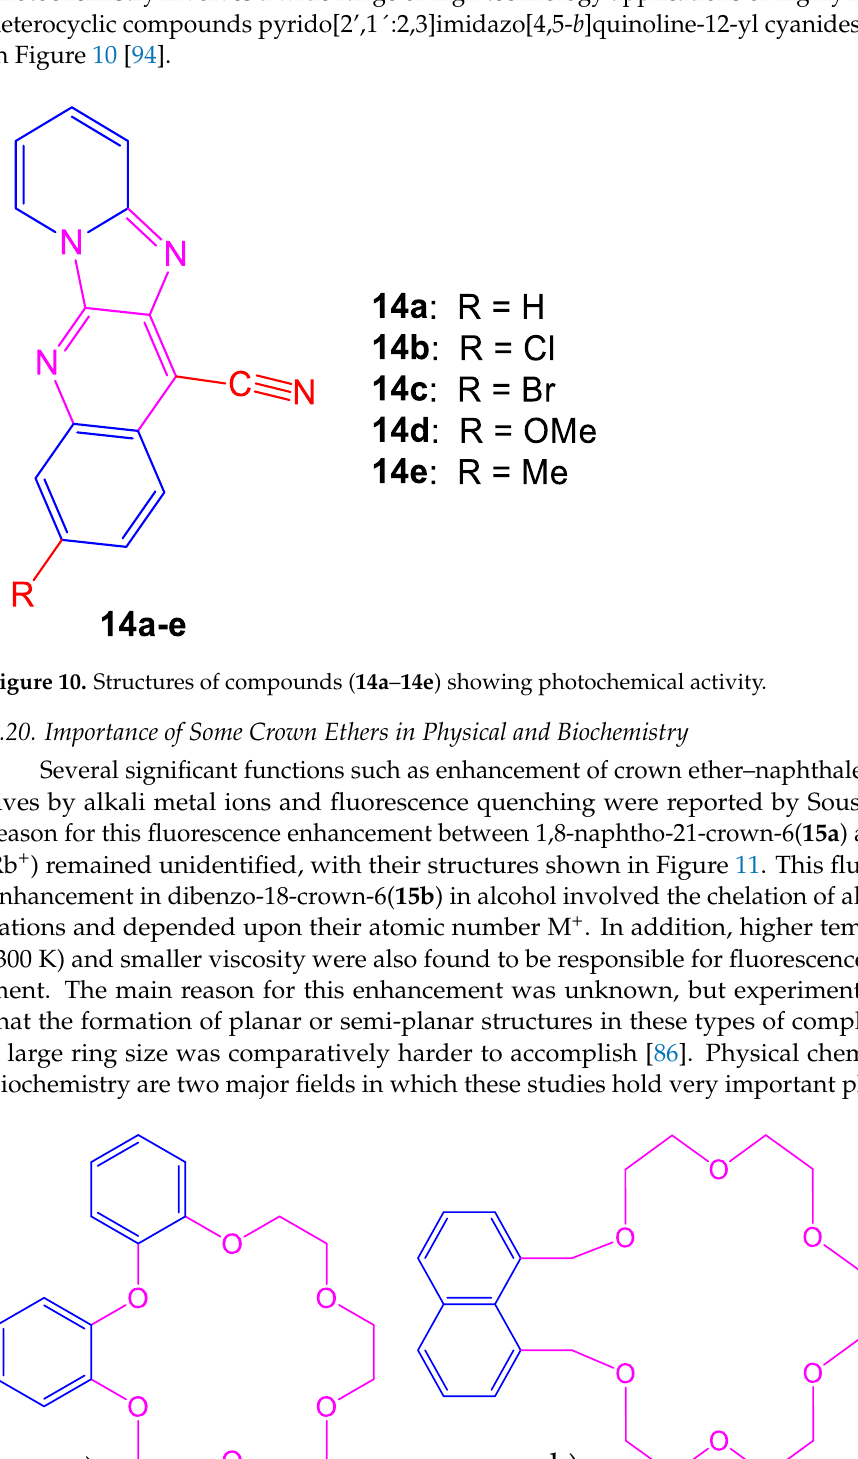
Figure 11. Structures of dibenzo-18-crown-6 (DC) and 1,8-naphtho-21-crown-6 ether ( 15a – b ). 2.21. Application of Benzothiazole Crown Ethers as Metal Ion Sensors Biological and environmental-related cations were considered hard to detect, but this was made possible by the most sensitive technique of fluorescence chemosensors. A few examples of such